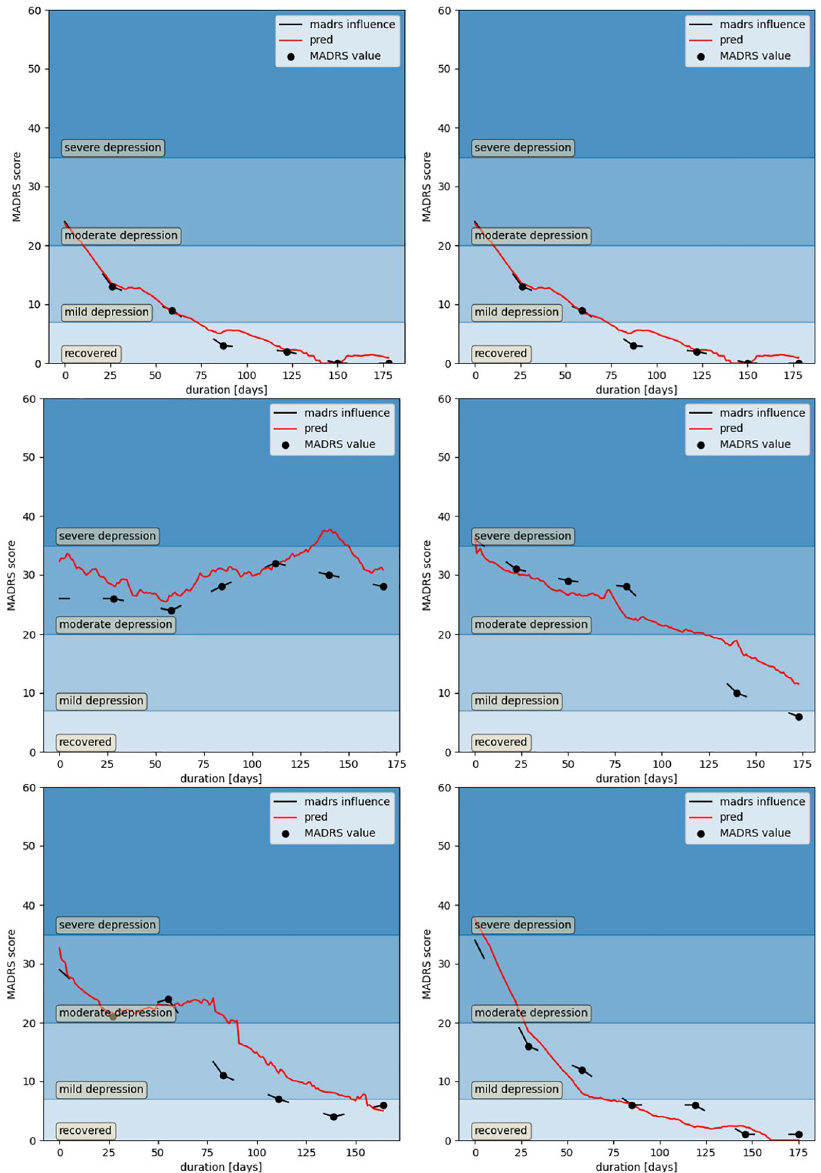
Figure 3. Comparison of the model’s prediction with the ground truth clinical labels. Predicted MADRS evolution (in red) and actual MADRS scores measured by the physician during the monthly clinic visits (black dots) for a sample of 6 selected patients. The lines around each visit represent the extended clinical labels to 5 days on either side of a clinical visit. The background color intensity indicates the 4 classes of depression symptom